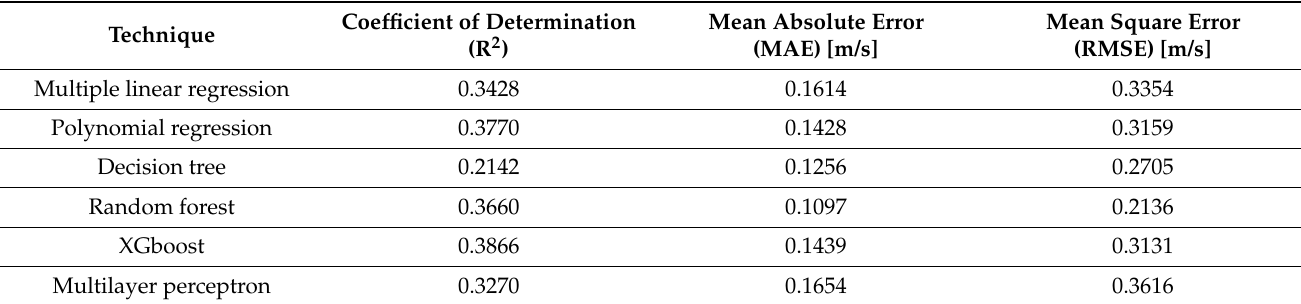
Table 10. Evaluation metrics for wind speed forecasting.